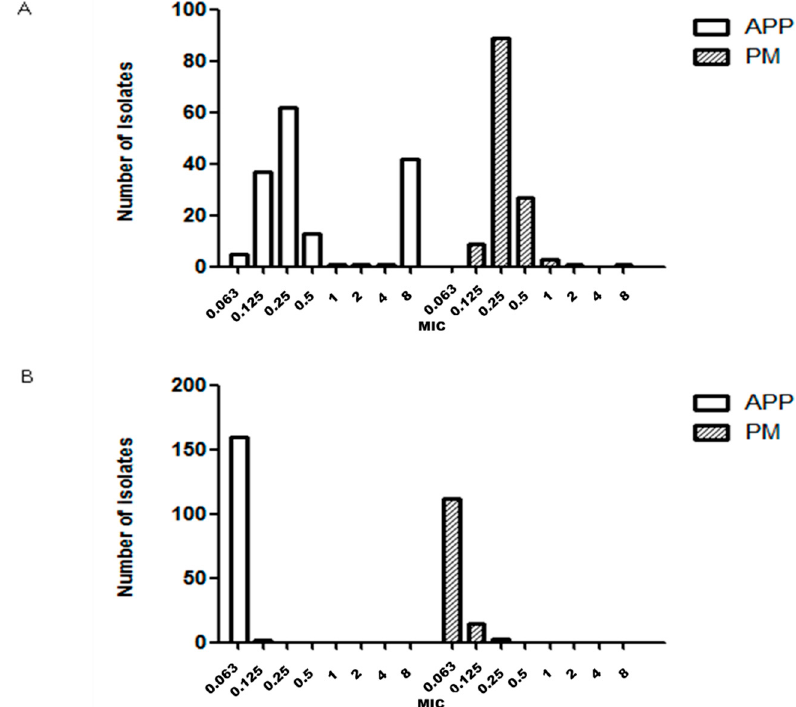
Figure 1. Minimum inhibitory concentration (MIC, µ g / mL) distribution of amoxicillin ( A ) and ceftiofur ( B ) for Actinobacillus pleuropneumoniae (APP) and Pasteurella multocida (PM) isolated from lungs of pigs with respiratory symptoms.